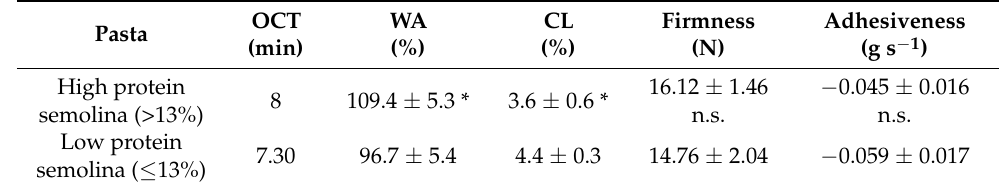
Table 3. Optimal cooking time (OCT), water absorption (WA), cooking loss (CL), firmness and adhesiveness of cooked pasta. * ( p < 0.05); n.s. (no significant differences); t -Test. OCT WA Pasta (min) (%) (%)